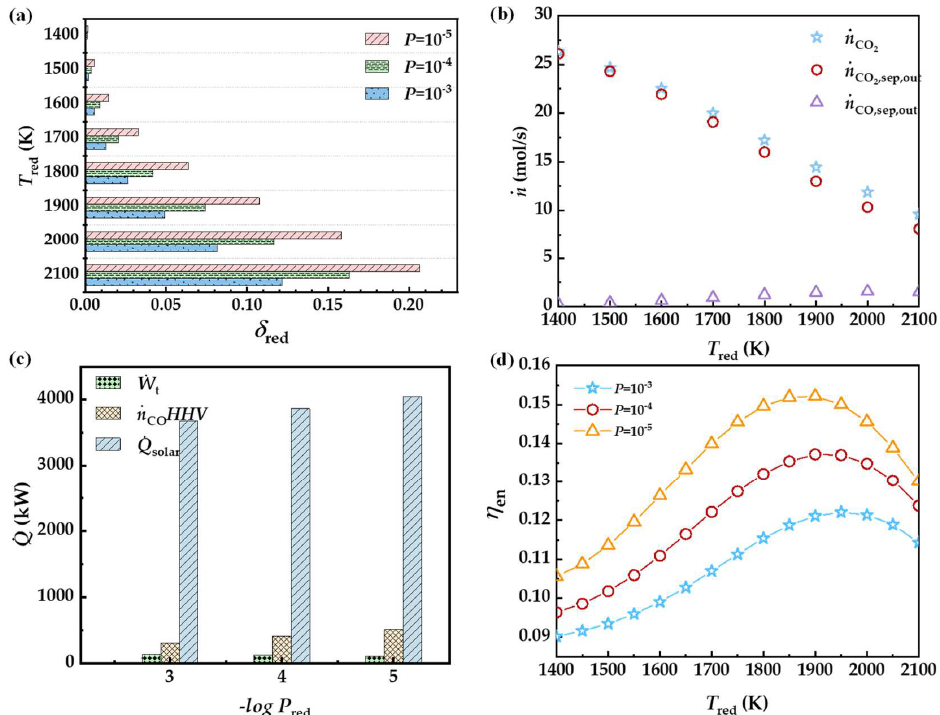
ɺ . . n , ɺ n , and n CO n CO , , and 2 CO 2 CO ,sep,out 2 2 ,sep,out . . ɺ ɺ . n HHV , and W , ɺ Q ( T red = 1900K), ( d ) influence n CO HHV , and W t , Q solar ( T red = 1900 K), ( d ) influence CO t solar